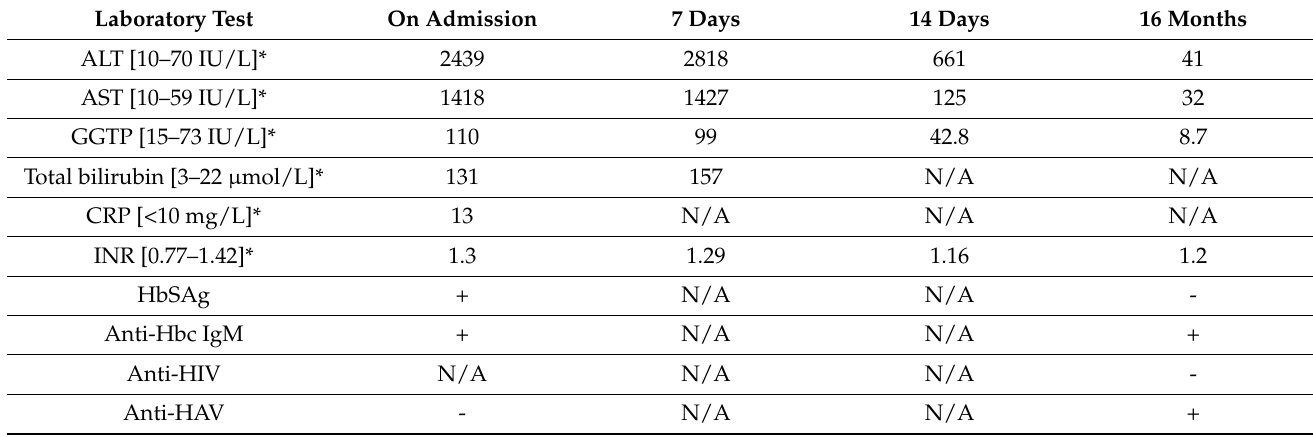
Table 1. Laboratory features of the patient on admission 7 days after admission, 14 days after admission, and 16 months after discharge of the